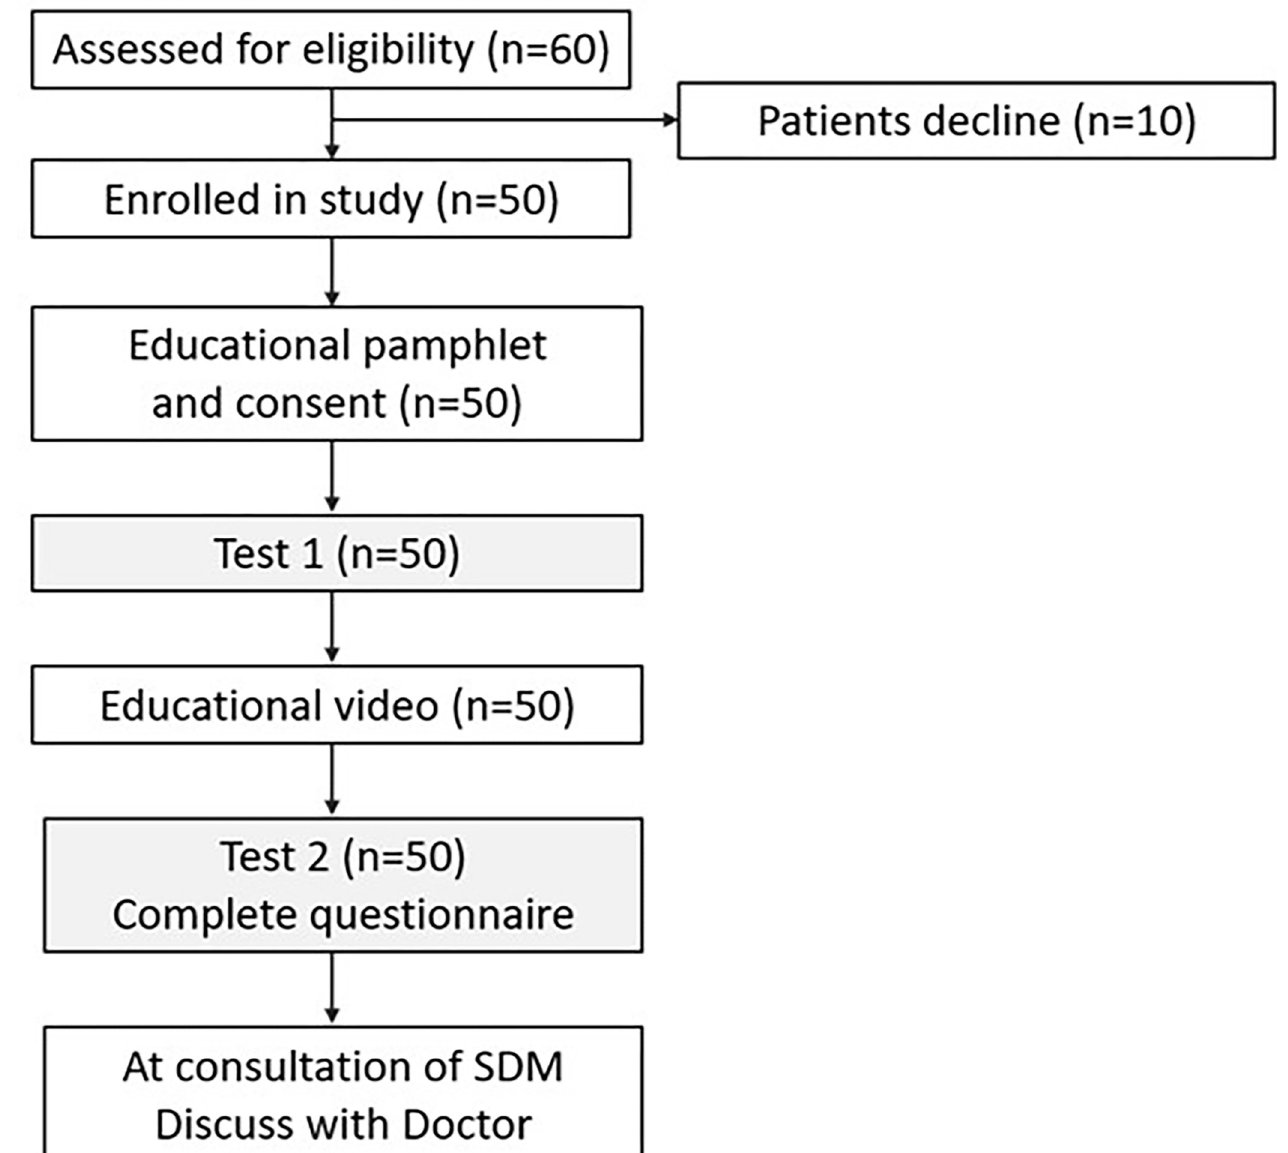
Fig 1. The flowchart of study design and participants selection. SDM, Shared